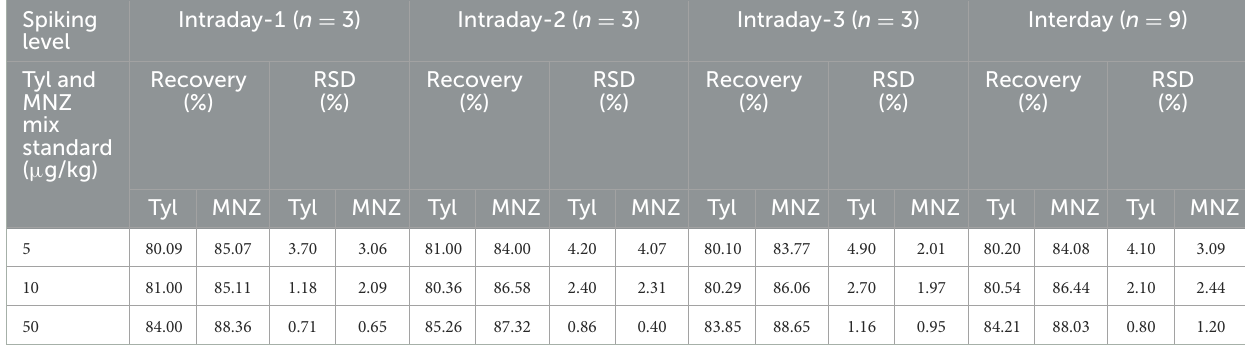
TABLE 3 Intraday and interday recovery of Tyl and MNZ in a shrimp sample. Spiking